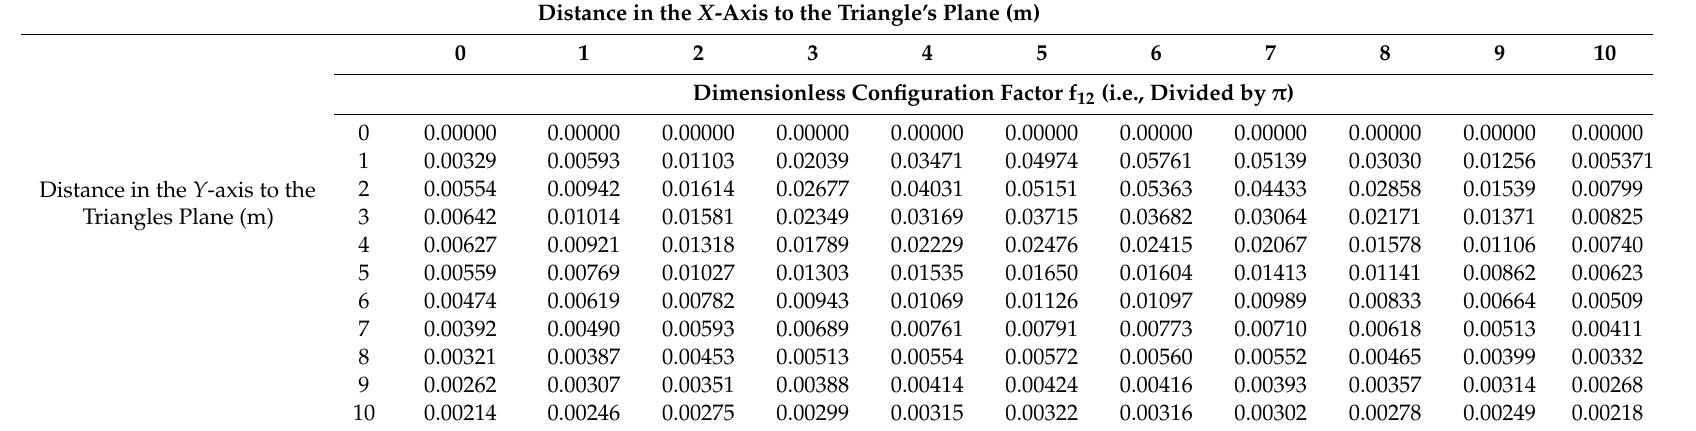
Table 3. Configuration factors of an area of 10 × 10 m 2 illuminated by a ‘scalene triangle’. Distance in the X -Axis to the Triangle’s Plane